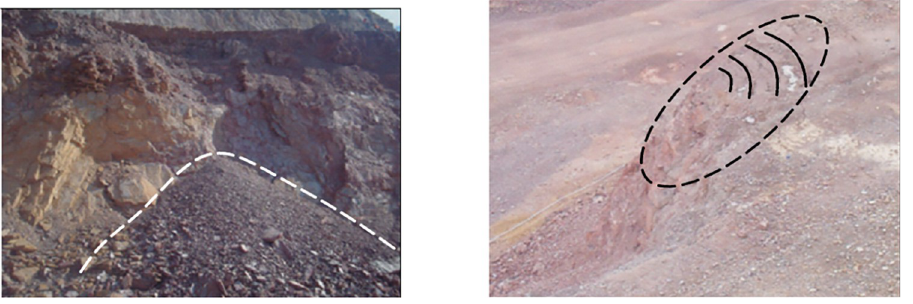
Fig 5. Local failure of